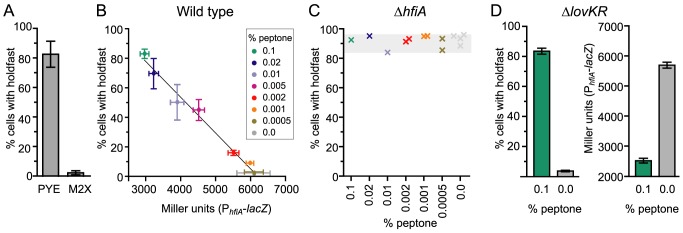
Nutrient environment affects hfiA transcription and the probability of holdfast development.
A. Quantification of WGA-Alexa595 stained holdfast on wild-type CB15 cells grown in complex medium (PYE) or defined minimal medium (M2X). Bars represent the mean ± s.d. of 12 (PYE) or 18 (M2X) independent samples. At least 300 cells per sample were counted. B. Holdfast development and hfiA transcription are inversely correlated and dependent on the growth medium. Cultures grown in M2X supplemented with increasing amounts of peptone were assayed at a final density of 0.05–0.15 OD660. Holdfast were assessed as above in 4–8 independent cultures of wild-type cells per condition (mean ± s.e.m). hfiA transcription was assessed in 6–12 independent cultures of wild-type carrying the pRKlac290-PhfiA reporter plasmid per condition (mean ± s.e.m.). C. HfiA is required for nutrient dependent regulation of holdfast development. Holdfast were counted, as above, on ΔhfiA cultures grown M2X supplemented with a range of peptone concentrations. Each x represents holdfast counts in an individual culture of ΔhfiA cells colored by growth medium. D. Nutrient-dependent regulation of PhfiA and holdfast probability does not require lovK and lovR. As above, holdfast were assessed in ΔlovKR cells in 6 independent cultures per condition (mean ± s.e.m.). β-galactosidase activity was measured in ΔlovKR cells bearing the pRKlac290-PhfiA reporter plasmid (n = 10 independent cultures per condition; mean ± s.e.m).